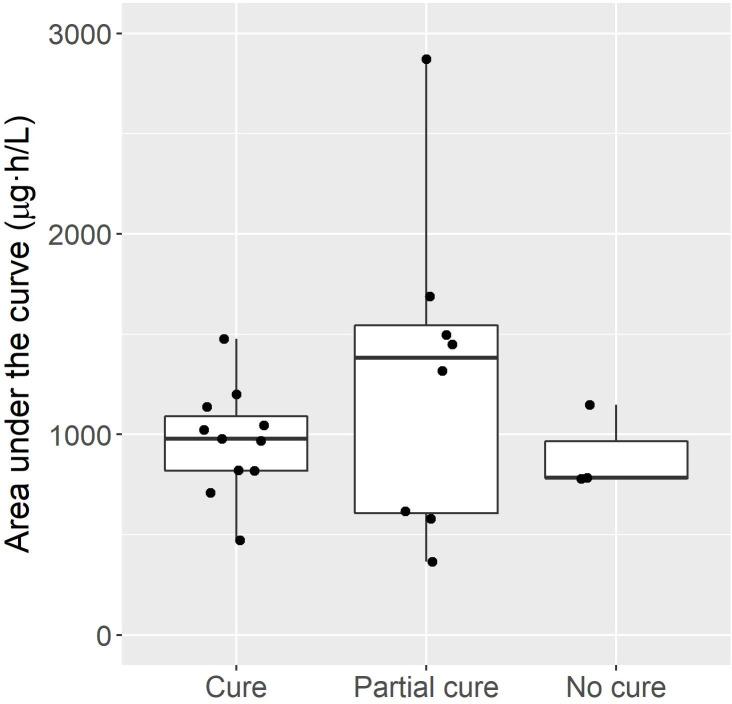
Drug exposures (area under the curve) vs clinical responses from children enrolled in the current study.